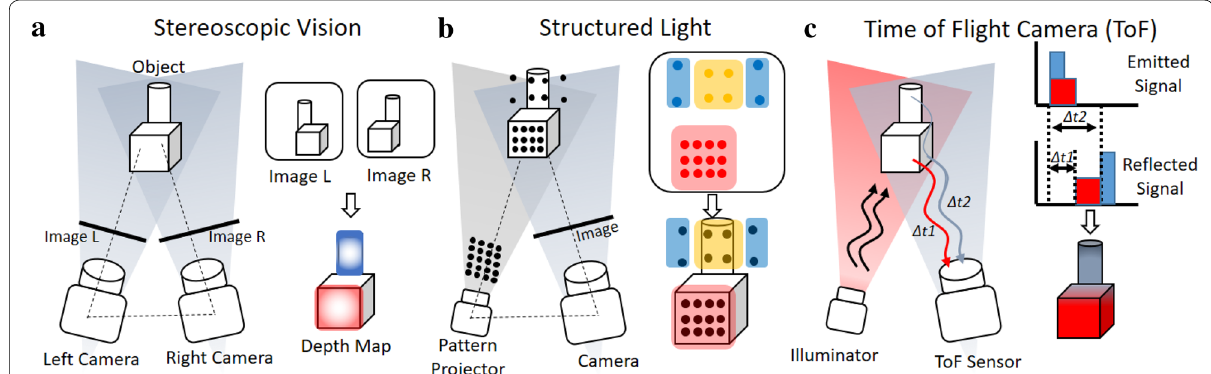
Fig. 1 Schematic illustration of three representing techniques for 3D surface imaging and their principles; a stereoscopic imaging, b structured light, and c time‑of‑flight (ToF)